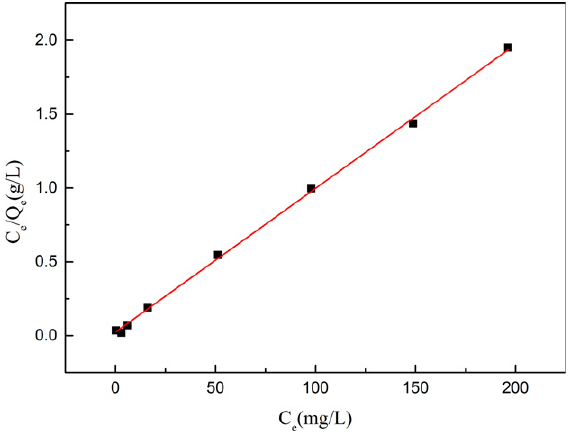
Figure 15: Linearized Langmuir plots for lead ions on the amino- functionalizaed MCM-41 adsorbent